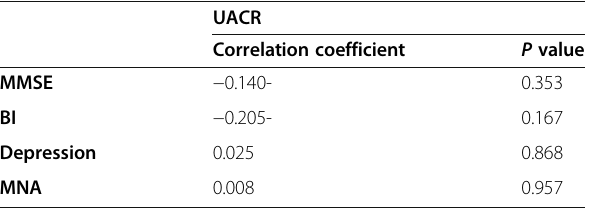
Table 4 The relation between UACR and MMSE, BI, depression, and MNA in geriatric population